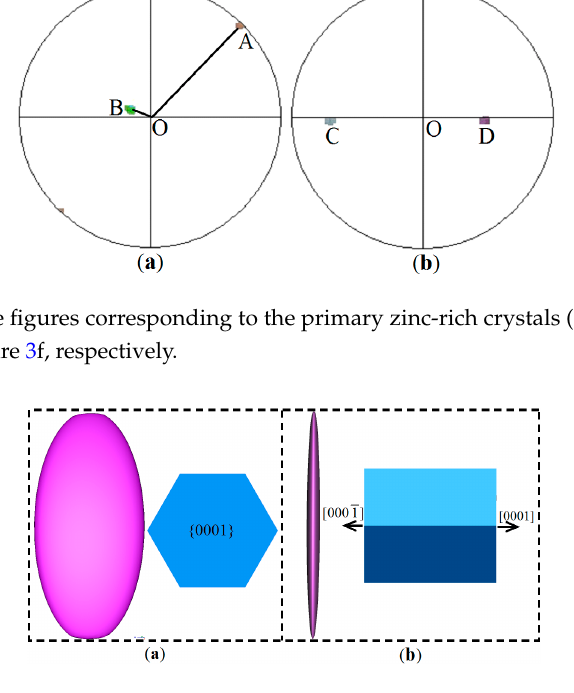
Figure 7. Schematic morphology of a primary zinc-rich crystal in three dimensions: ( a ) front and ( b ) side views. The hexagonal unit cells denote its orientations relative to the observation plane.